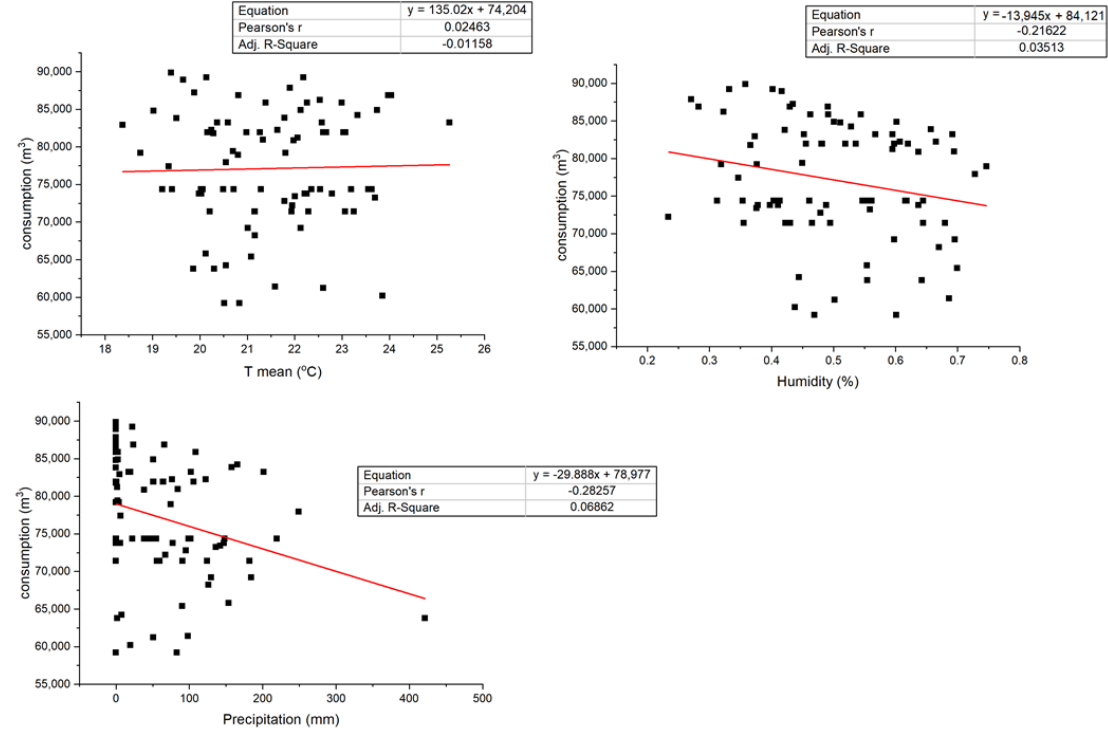
Figure 9. Monthly water consumption trendline for the climate variable of Ziway (2012 – 2020).